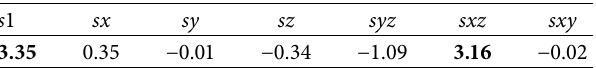
Table 3: Maximum principal tensile stress value and its stress component of downstream of the dam under no-slip